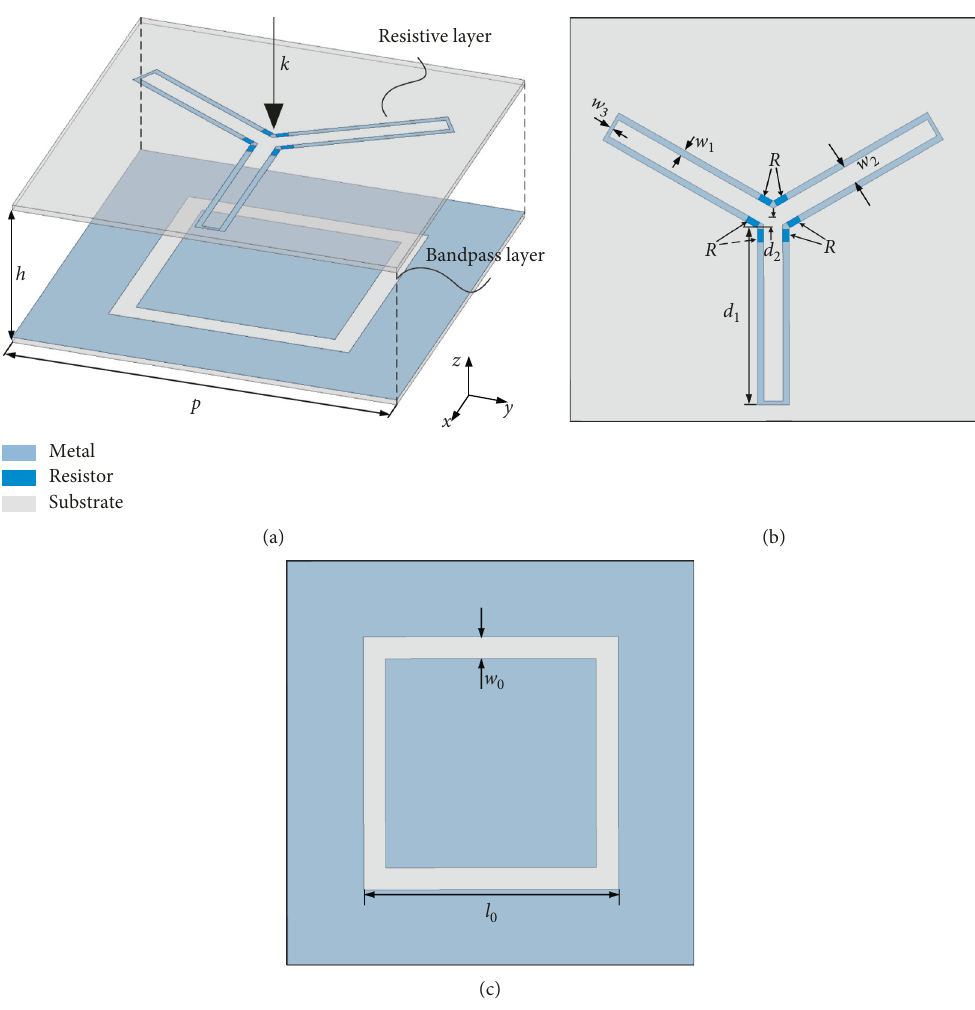
Figure 2: (a) 3-D view of preliminary design. (b) Resistive layer on the top. (c) Bandpass layer at the bottom (geometric dimensions: p � 32mm, h � 13 mm, w t � 0.508mm, and ε r � 3.48).